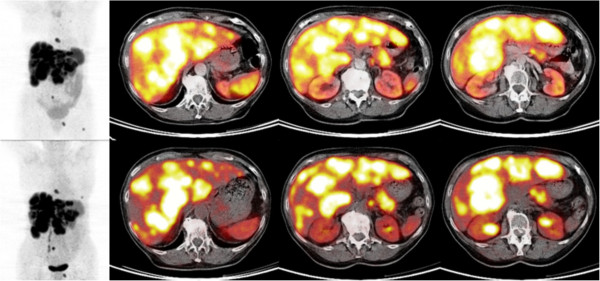
Pretreatment (above) and intra-therapeutic (below) 68Ga-DOTATOC PET/CT images of a patient. The patient has liver and bone metastases of a P-NET (tail of the pancreas) and high hepatic tumor disease burden. The significant increase of tumor-to-nontumor SUV ratios (SUVT/L and SUVT/S) after 177Lu-octreotate administration (+111.4% and +142.2%, respectively, both p < 0.001) is visible on the images.